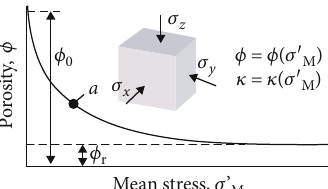
Figure 3: Variation of the porosity ϕ with the mean stress σ (extracted from